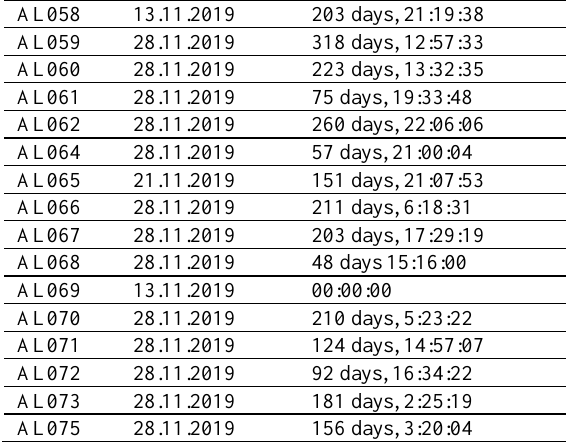
Table 4. Devices duration analysis of the winter